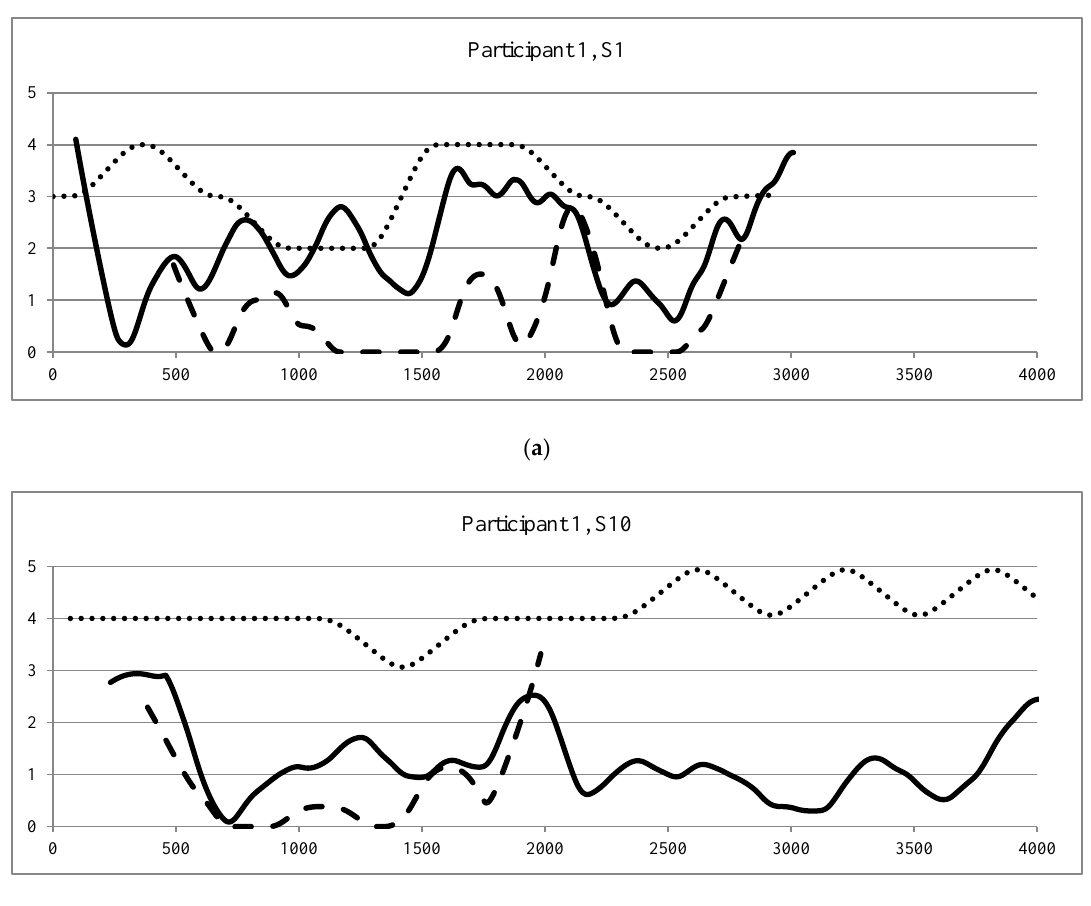
Figure 1. ( a ) Graphic representation of the first therapy session (Notes: Data points of participant 1 during the first therapy session (S1), smoothed with LOESS as a function of time (in seconds). Legend: —Verbal initiative; —Spontaneous touch; …… Posture); ( b ) Graphic representation of the last therapy session (Notes: Data points of participant 1 during the last therapy session (S10), smoothed with LOESS as a function of time (in seconds). Legend: —Verbal initiative. —Spontaneous touch……Posture).